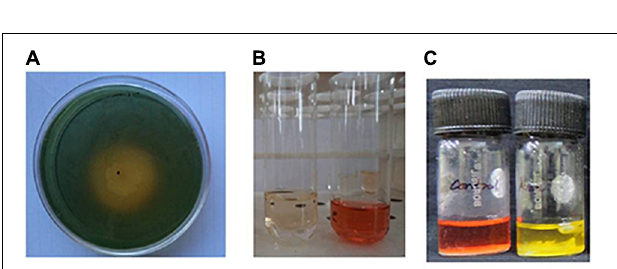
FIGURE 2 | Qualitative estimation of plant growth-promoting properties of BHU-AV3 isolate. (A) Siderophore assay – yellow zone indicates positive result; (B) IAA production assay – development of pink color indicates positive result; (C) Pi solubilization test – development of red to yellow color indicates positive result.